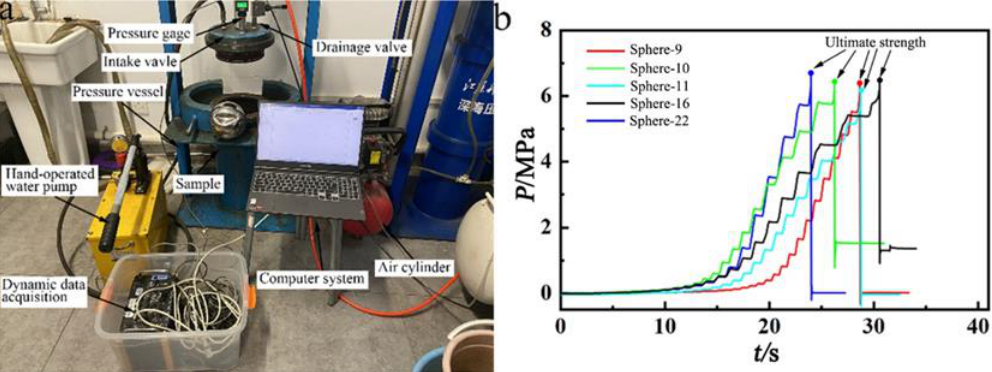
Figure 7. Hydrostatic pressure test: ( a ) test site; ( b ) typical loading curves.